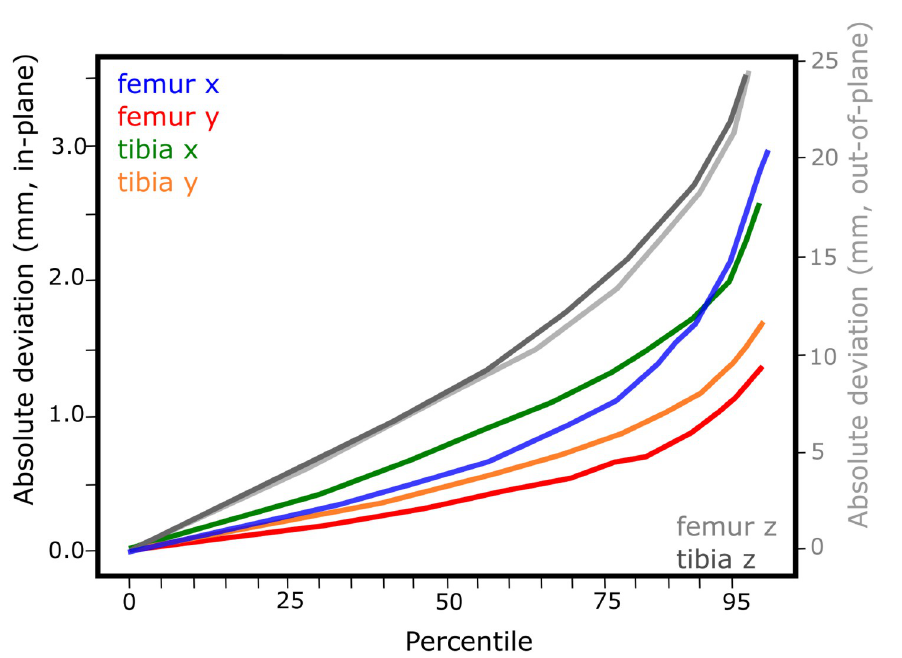
Fig 4. Translation performance for the individualised 2-iteration DAMN on the test-set.